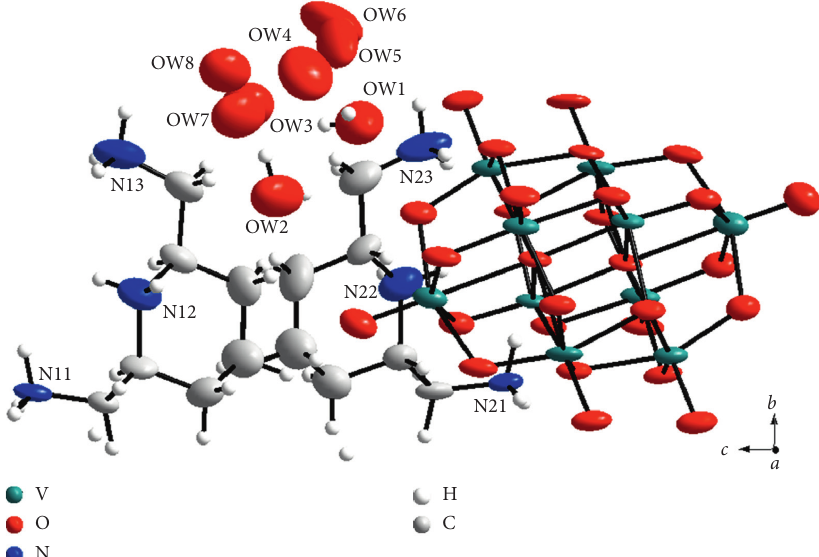
Figure 1: A view of the formula unit of (C